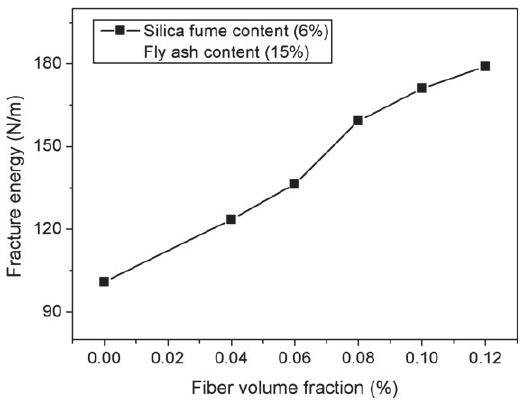
Figure 5 Effect of the polypropylene fiber on effective crack length.